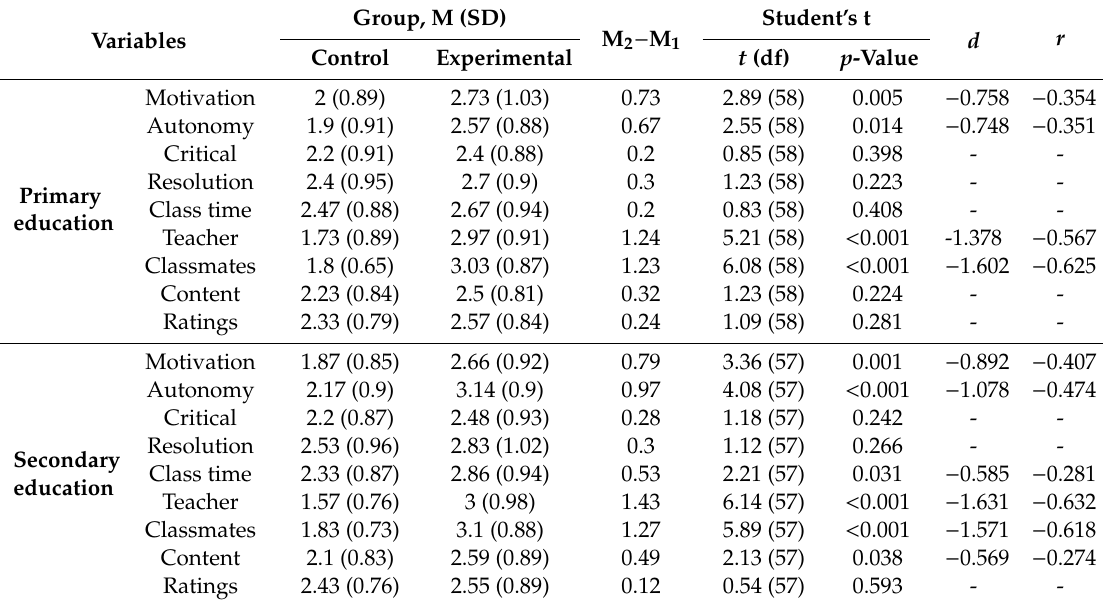
Figure 2. Intergroup comparison in interactive dimension. Table 6. Study of the value of independence between control and experimental